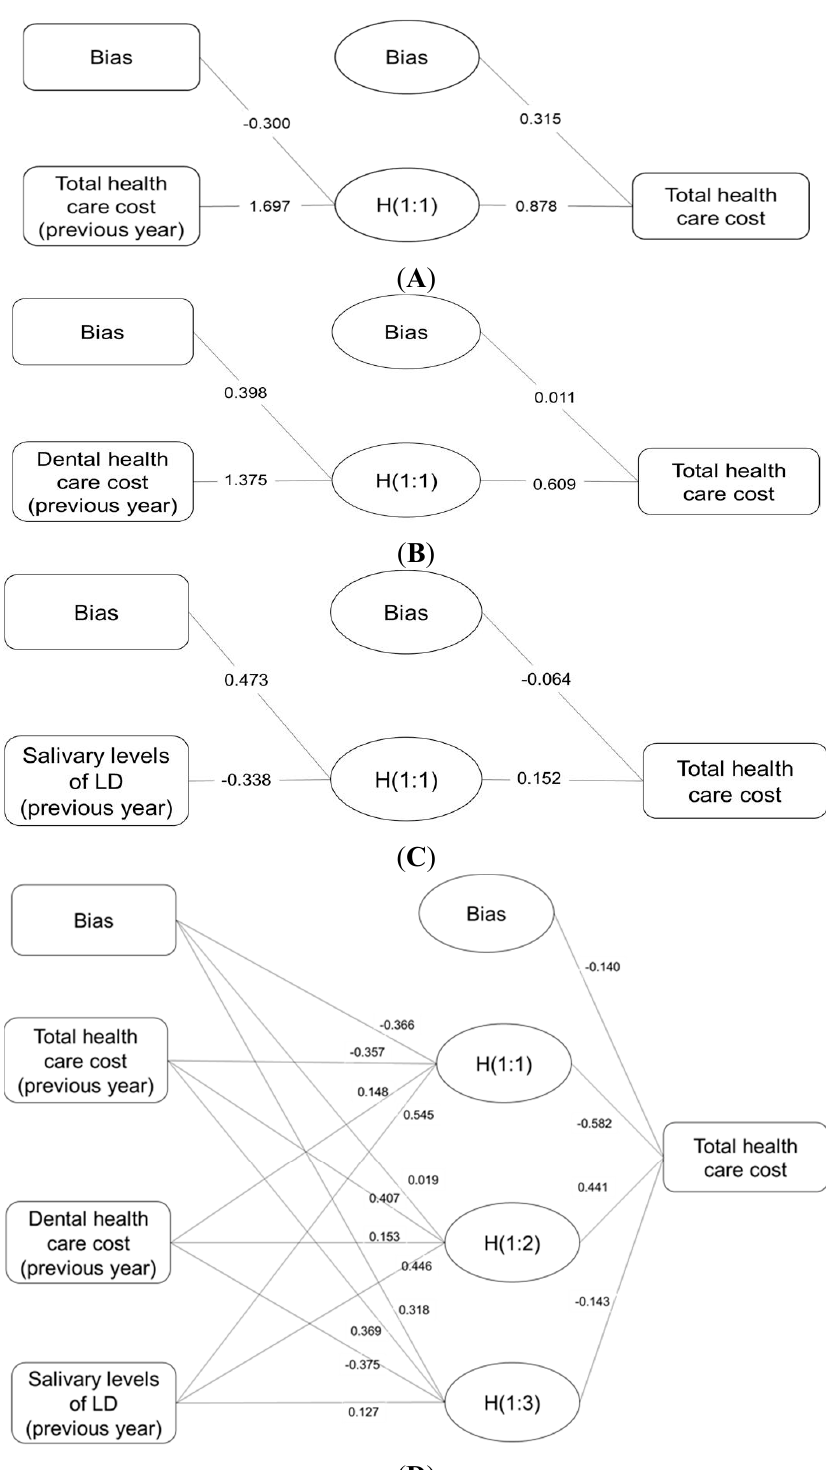
Figure 2. Models by a single independent variable. ( A ) health care costs from the previous year; ( B ) dental health care costs from the previous year; ( C ) salivary levels of LD from the previous year (2016); ( D ) Models by multiple these three independent variable.